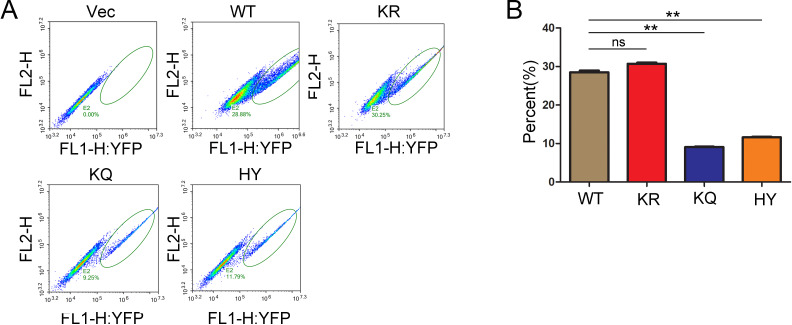
Polymerization of SIRT6.(A) Yellow fluorescence detection by FACS in HEK293 cells ectopically expressing vector only, SIRT6-WT, SIRT6-KR, SIRT6-KQ or SIRT6-HY via the BiFC system. Green ovals indicate yellow-fluorescence-positive cell population. (B) The percent of yellow-fluorescence-positive cells from each group shown in A. The data represent the means ± s.e.m., **p<0.01, ns: not significant, n = 3.